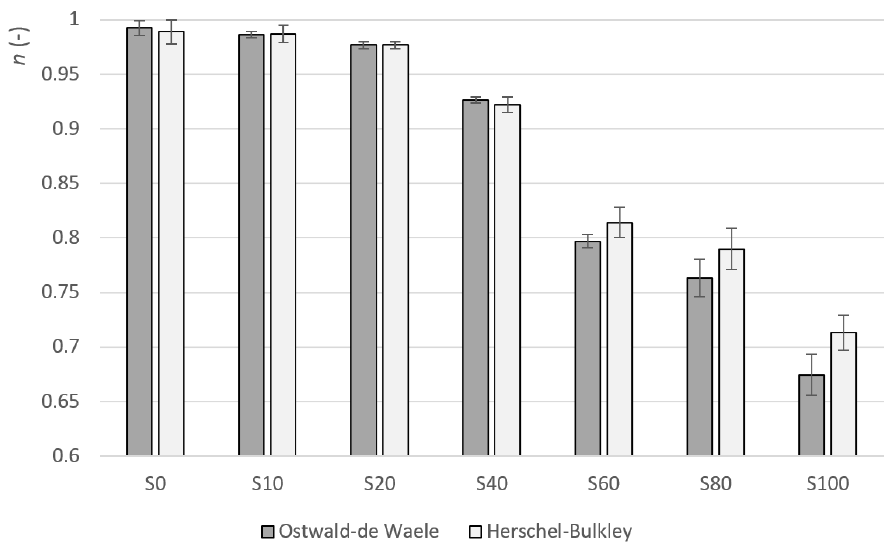
Figure 4. Flow index (cid:1866) average values for samples S0–S100.